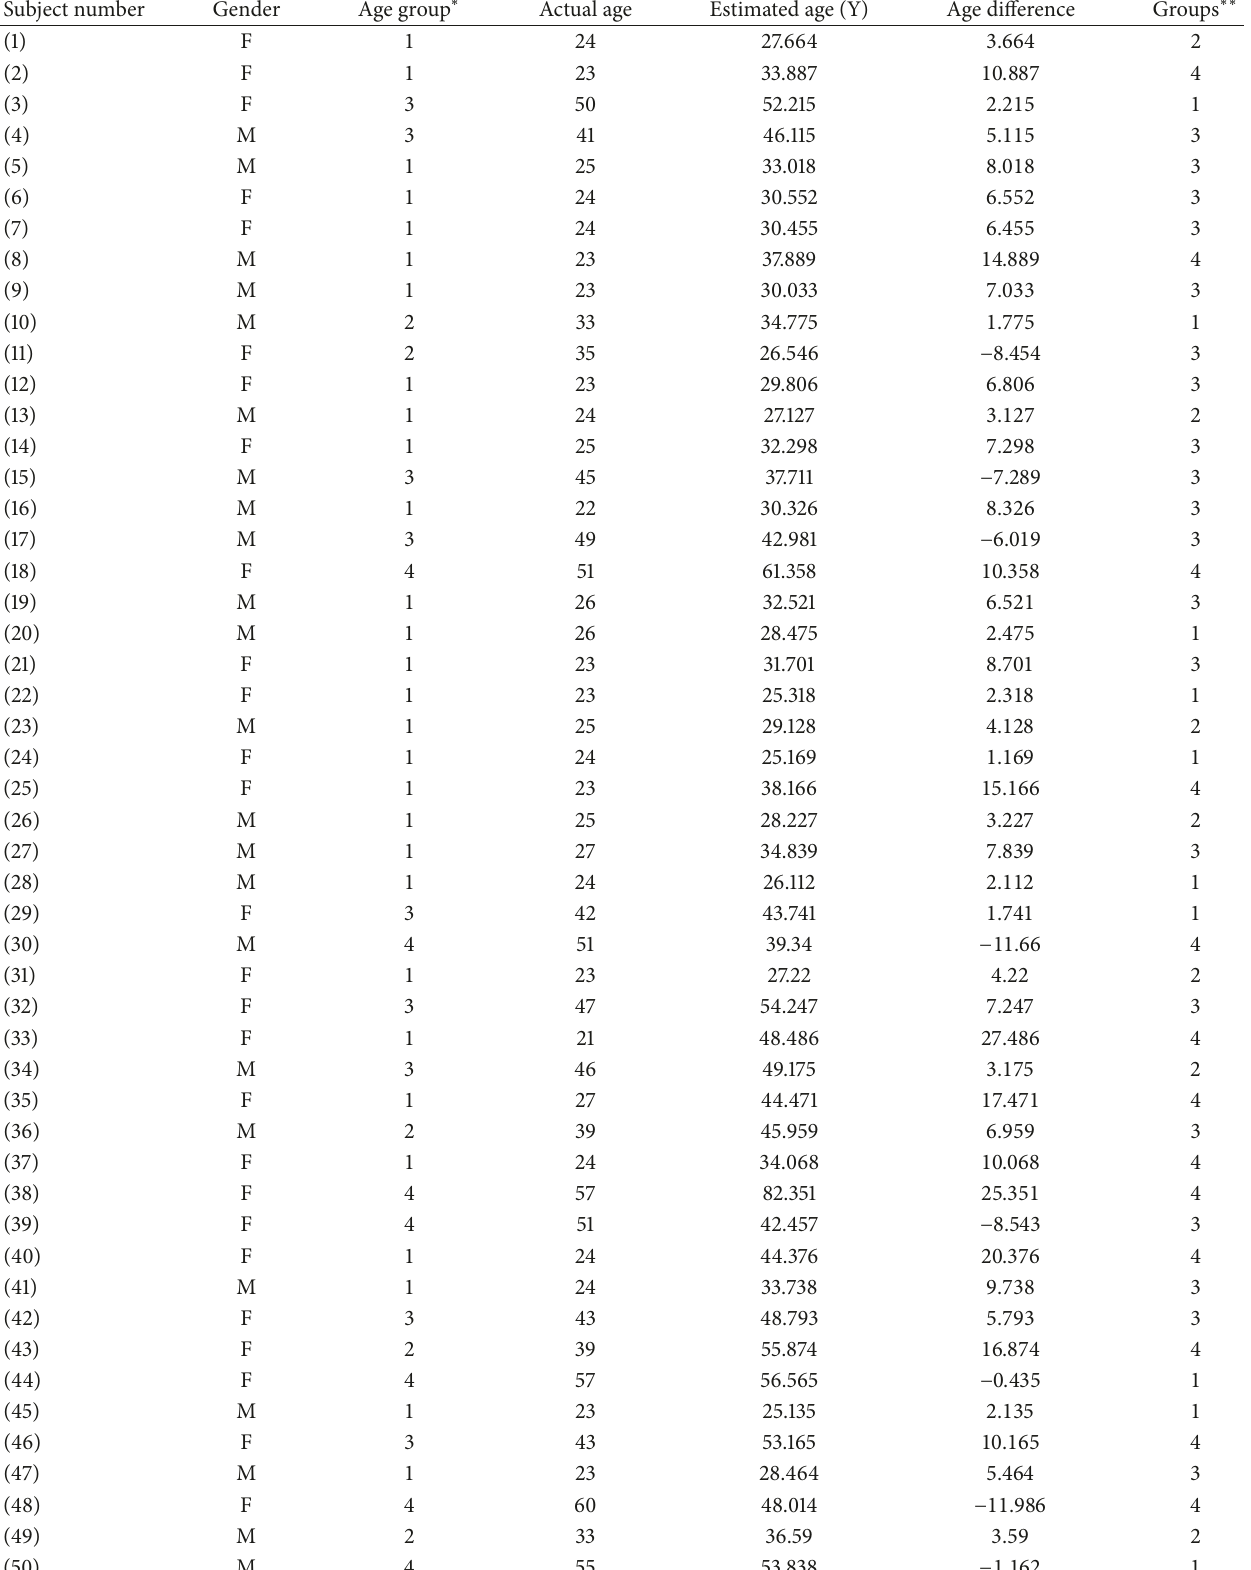
Table 9: Master chart of the details regarding the data of the samples included for the